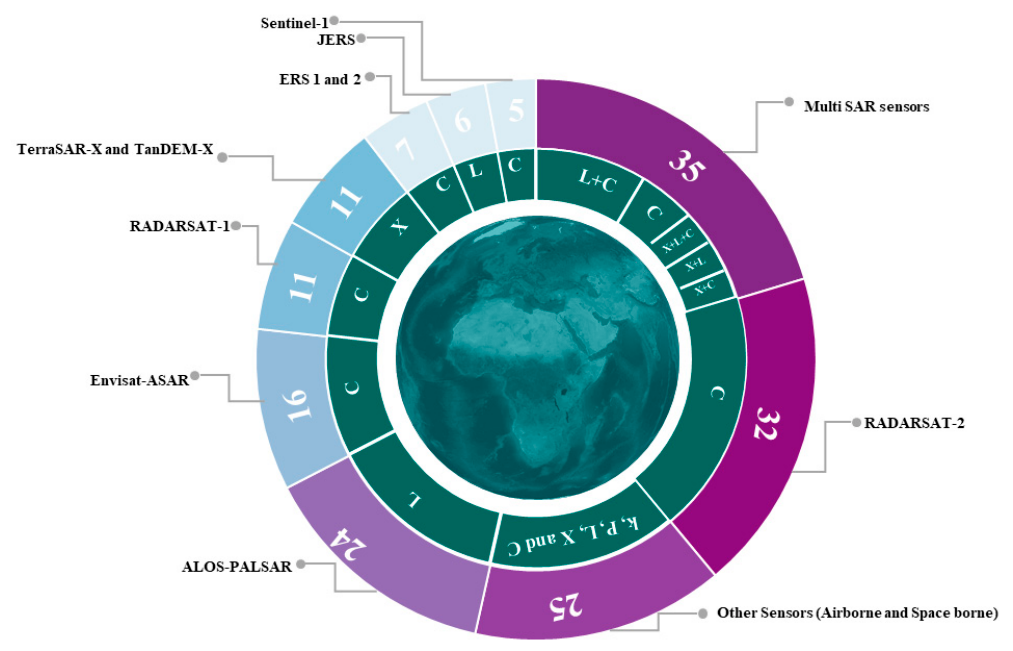
Figure 10. Number of studies for different SAR sensors. Airborne sensors (e.g., UAVSAR) and sensors with less than five studies are clustered as “other-sensors” in this figure. The multi-SAR sensors group includes all the studies that used more than one SAR sensor.